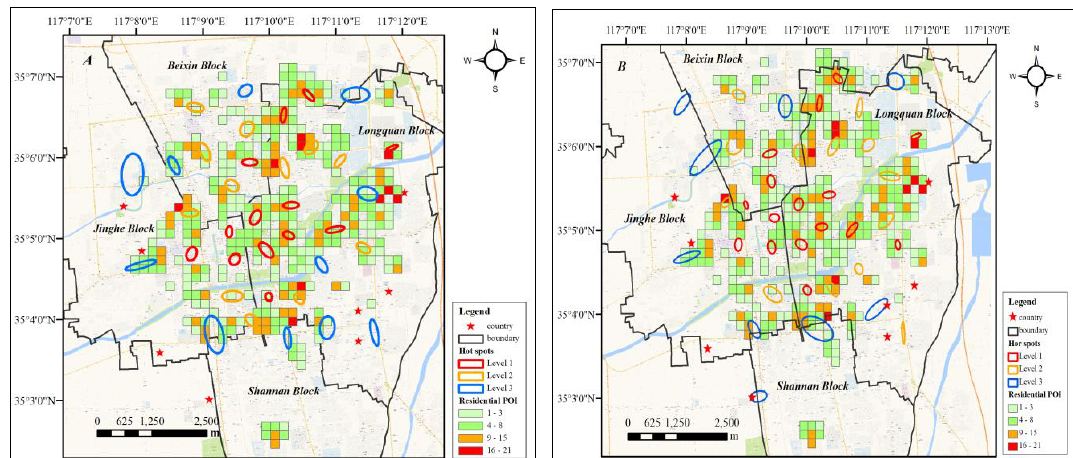
Figure 10. Hot spot results for different data sets. ( A ) Detected result of hot spots for the data set in the evening rush period. ( B ) Detected result of hot spots for the data set in the morning–evening rush period.